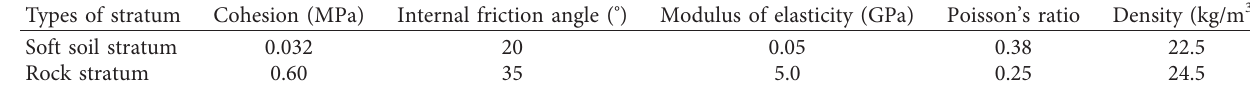
Table 1: The physical and mechanical parameters.